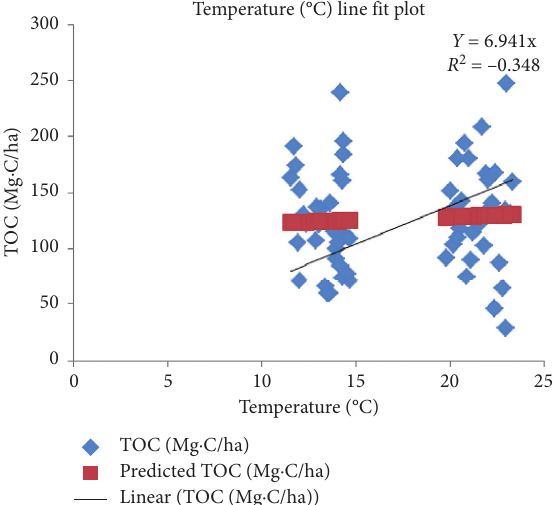
Figure 4: Relationship between temperature and soil carbon